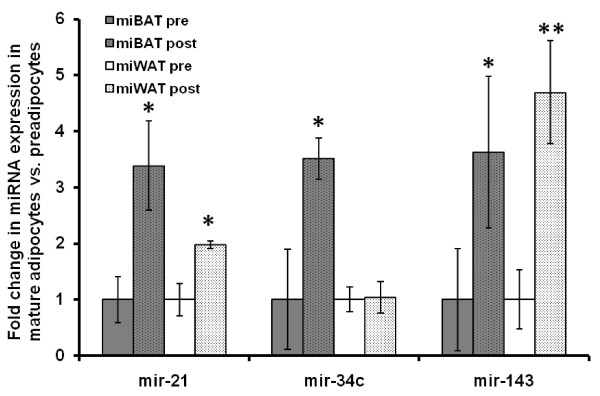
Expression levels of mir-21, mir-34c and mir-143 in primary murine brown and white preadipocytes and mature adipocytes (n = 3+3 for each tissue). miRNA expression levels are shown as fold change from their respective preadipocyte level and normalised to the small nucleolar RNA snoRNA142. * depicts p < 0.05, ** depicts p < 0.01.